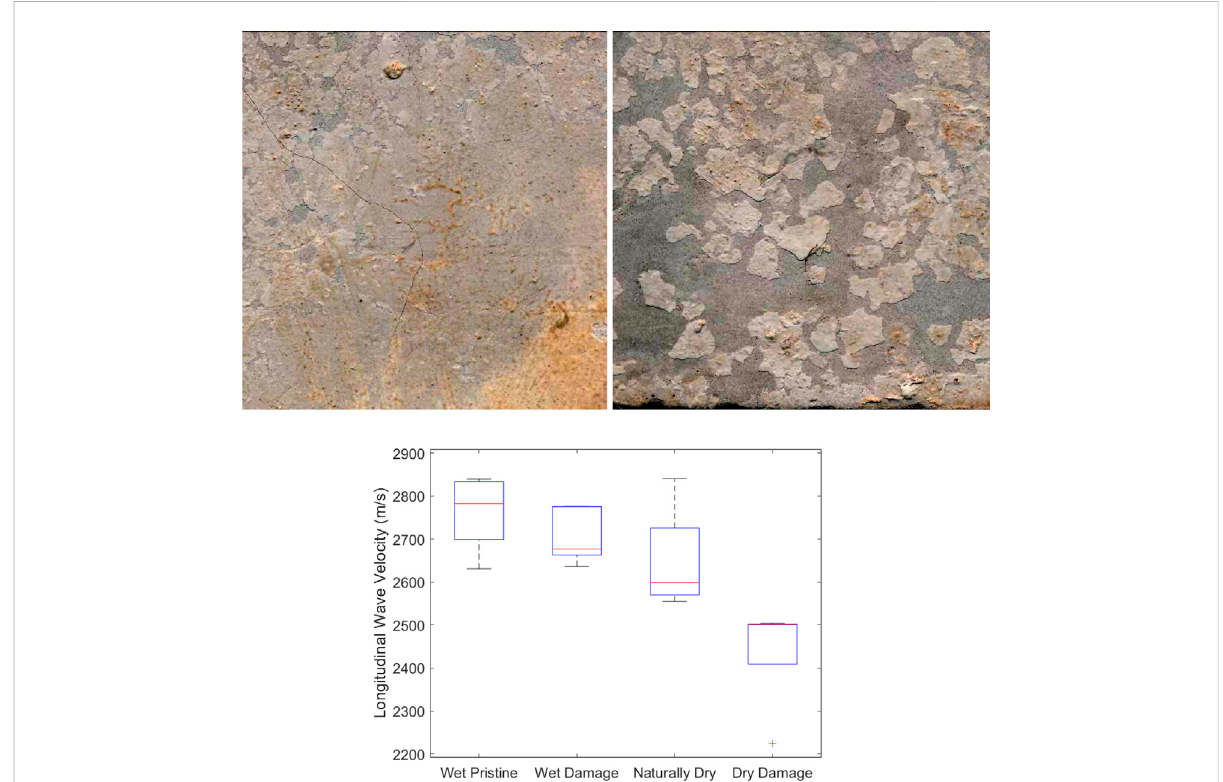
FIGURE 14 Surface photos, with enhanced contrast, to facilitate crack identi fi cation, of cement paste (w/c = 0.8) prisms with two thermal-cycle induced damage (top left) and undamaged naturally dried (top right) conditions. Vertical size of images is 2.5 cm. Ultrasonic pulse velocity measurement repeated three times for fi ve replicates of each sample condition group (Bottom). Black bars represent the 95% con fi dence intervals within each sample, the blue box represents the 50% con fi dence intervals, and the red line represents the median of the condition